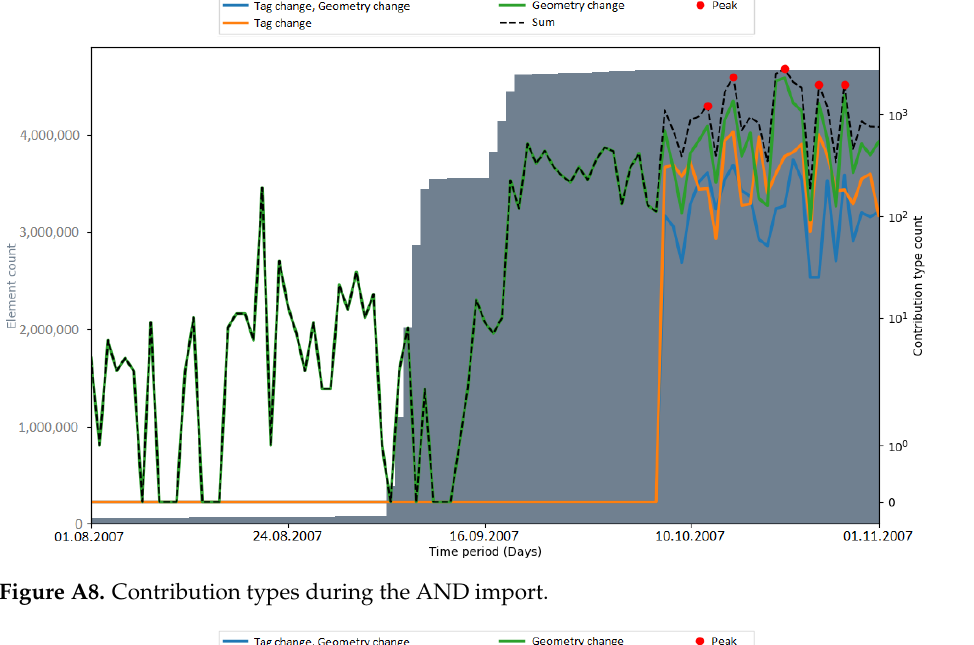
Figure A8. Contribution types during the AND import.